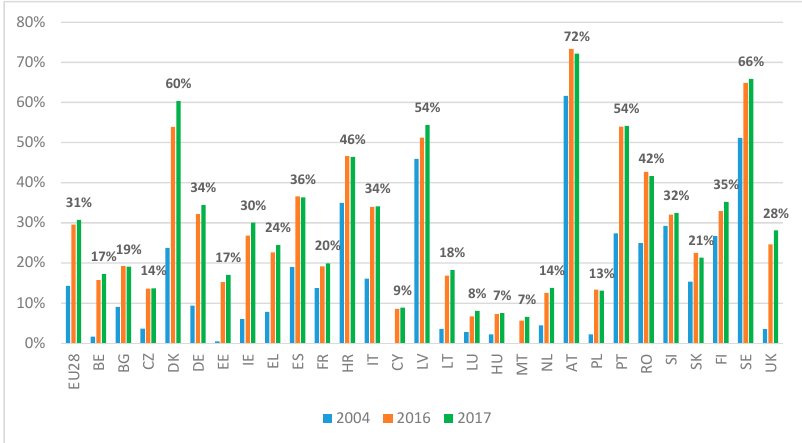
Figure 3. Share of renewable energy in transport, at the EU level, in 2017 and 2020 target. Source: own computations performed on data retrieved from Eurostat [18].